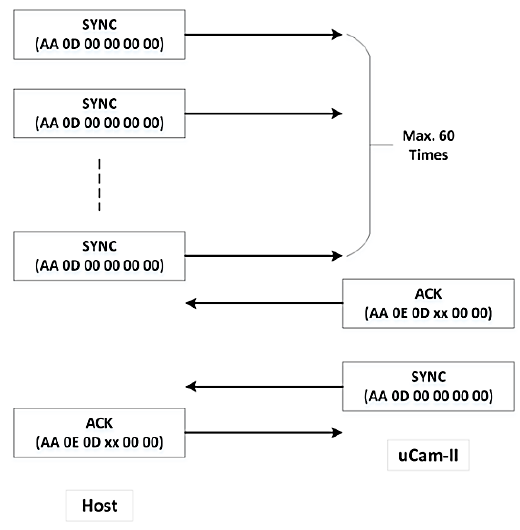
Figure 4. Synchronization process between uCAM-II and host.